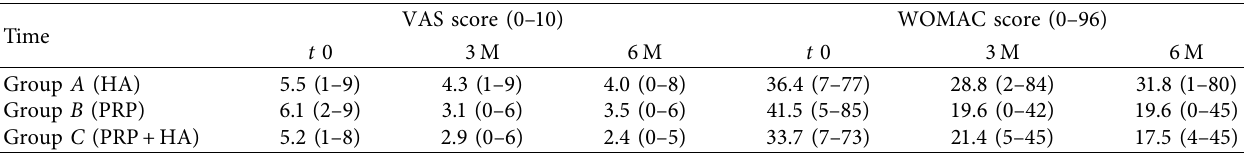
Table 1: Summary of the mean visual analogue scale (VAS) and Western Ontario McMaster Universities Osteoarthritis Index (WOMAC) values in our population, sorted per group.